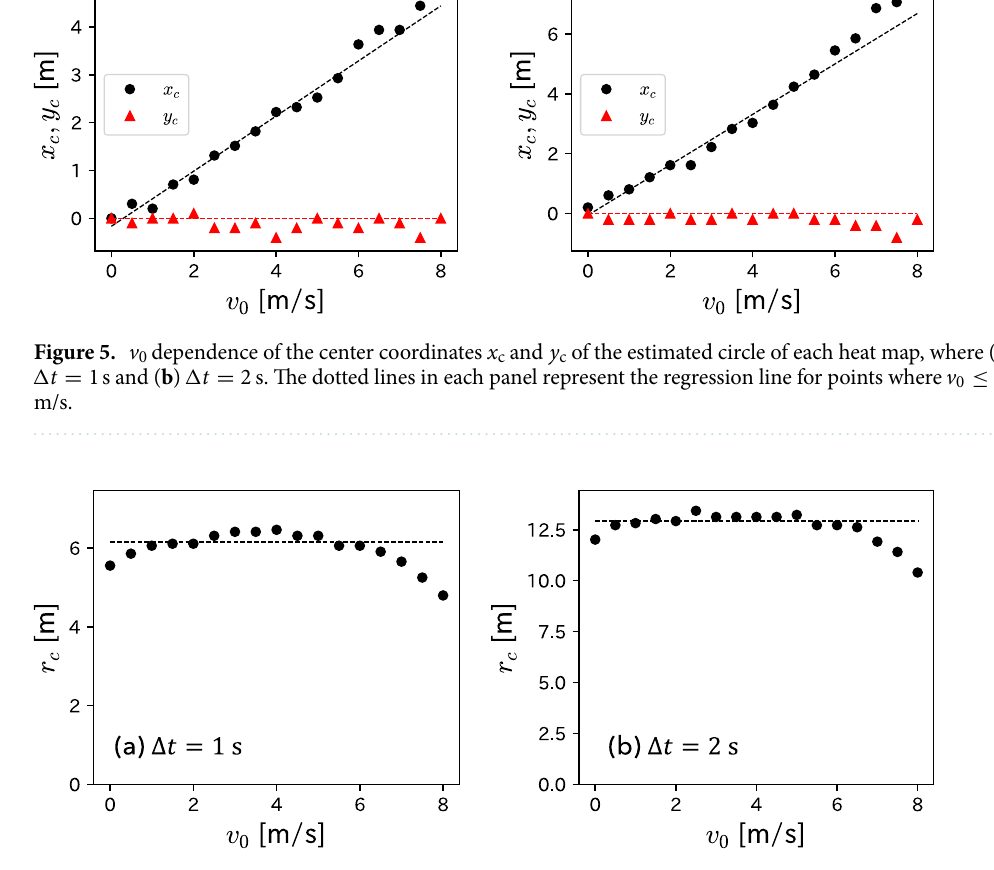
Figure 6. v 0 dependence of the radius r c of the estimated circle of each heat map. The dotted line represents r c = 6.16 m for ( a ) (cid:31) t = 1 s, and r c = 12.94 m for ( b ) (cid:31) t = 2 s. These values are obtained by averaging the points where v 0 ≤ 6